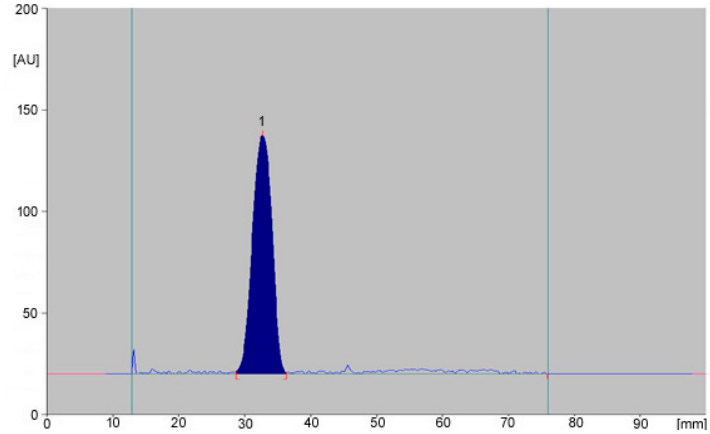
Figure 4. An example of chromatograms obtained for Onsior preparation containing robenacoxib.